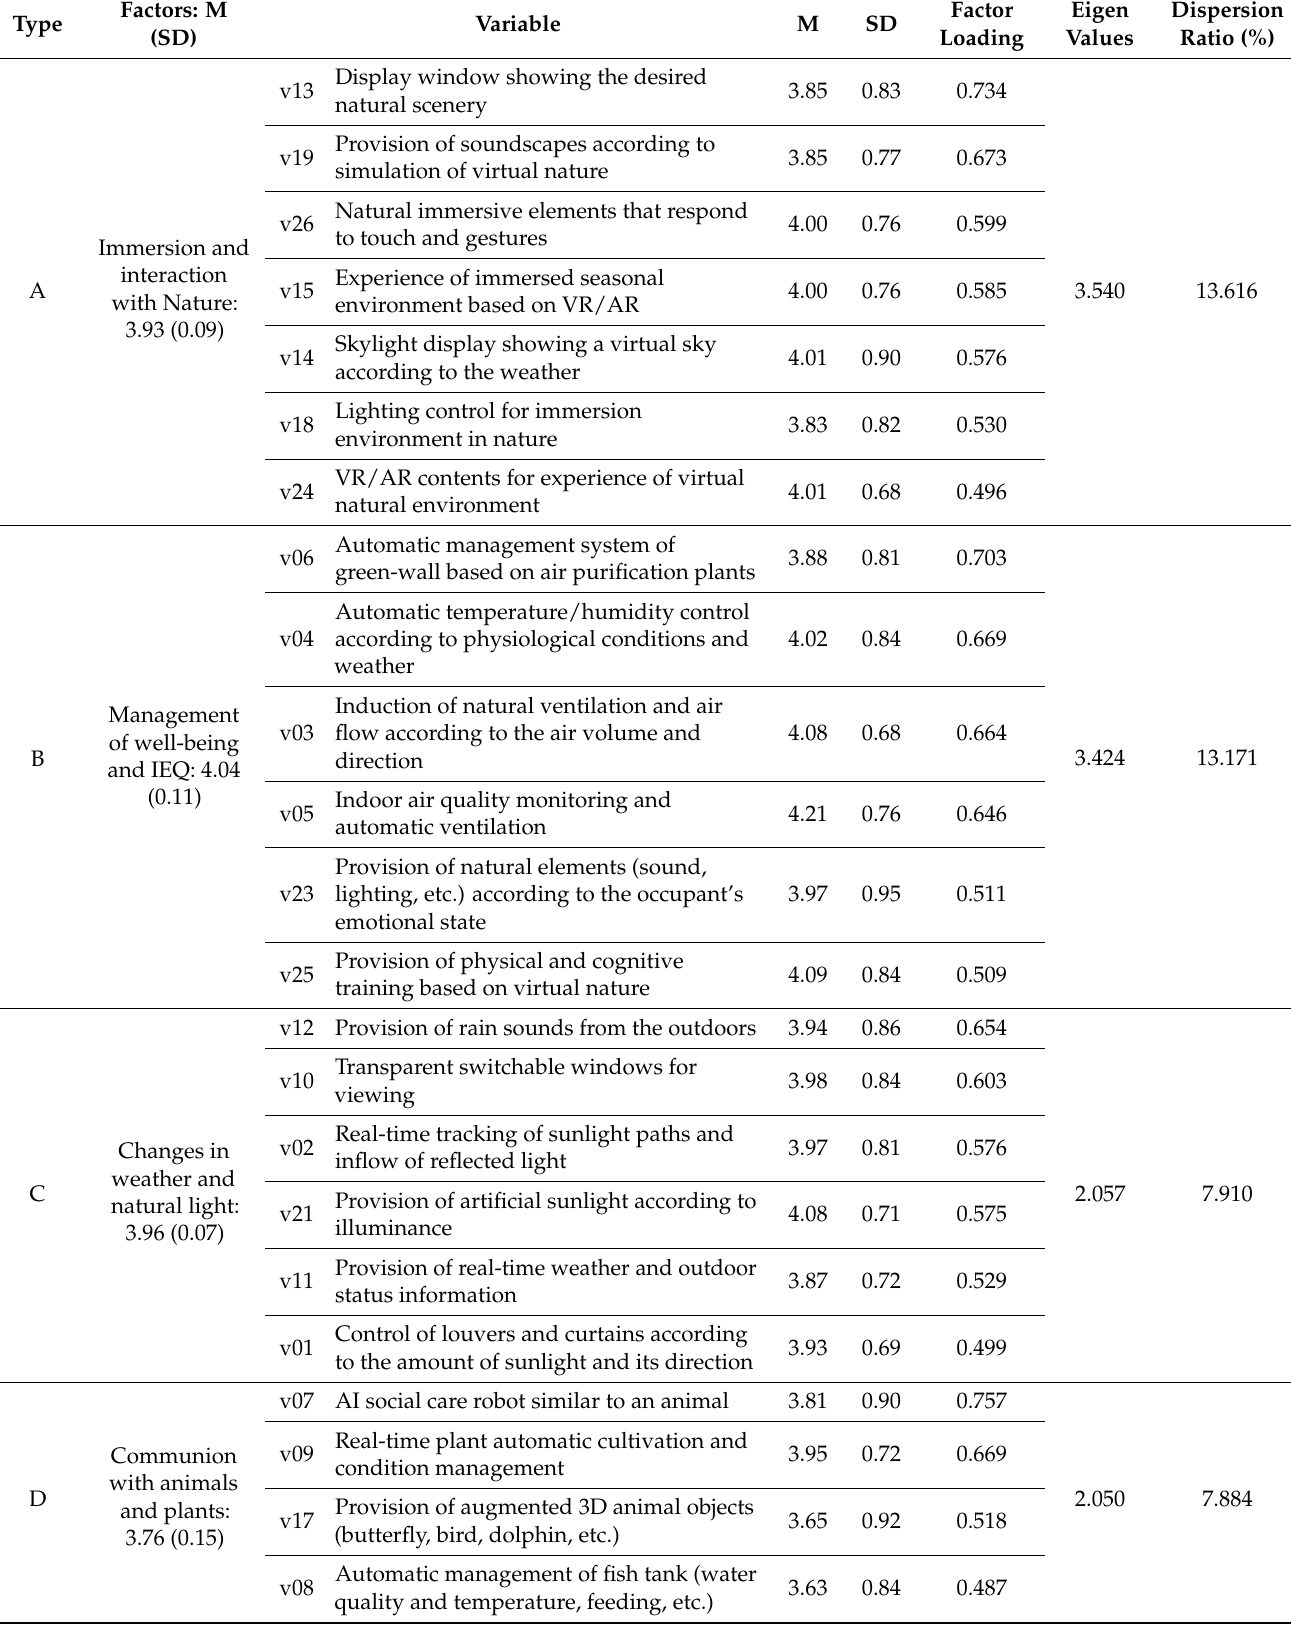
Table 5. Results of descriptive statistics and factor